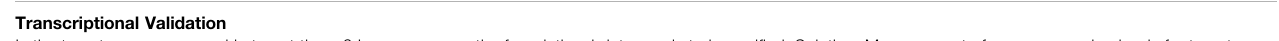
TABLE 3 | Elements related to translational